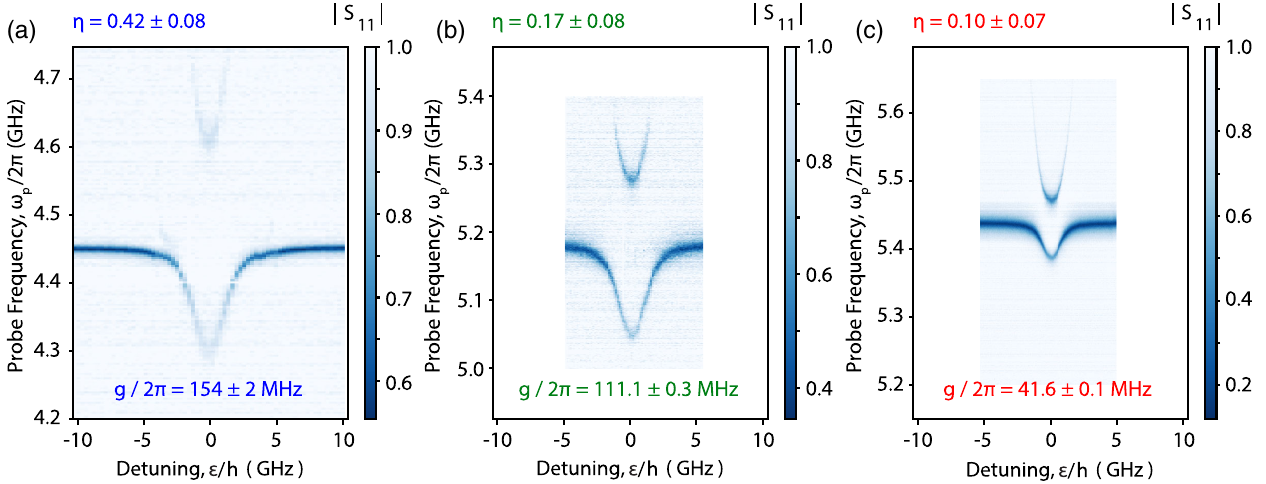
FIG. 12. Response of the SQUID array resonator reflectance amplitude j S 11 j versus DQD detuning ϵ in correspondence of three distinct dipole strengths (a) η ∼ 0 . 42 (cid:3) 0 . 08 (blue), (b) η ∼ 0 . 17 (cid:3) 0 . 08 (green), and (c) η ∼ 0 . 10 (cid:3) 0 . 07 (red) [the corresponding DQD charge stability diagrams are reported in Figs. 2(e), 2(d), and 2(c), respectively]. The three resonant spectrums are obtained by tuning the SQUID array in resonance with the DQD charge excitation frequency for ϵ ¼ 0 . Data are already reported in Figs. 3(a) –